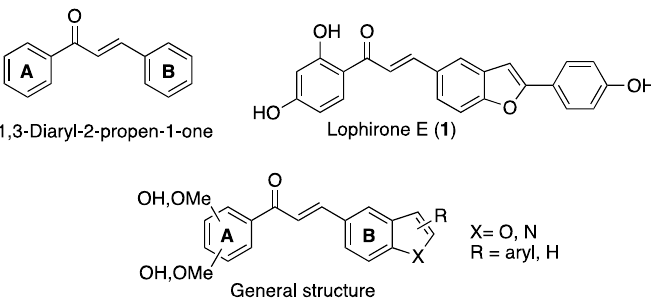
Figure 1. General structures of chalcones and compounds discussed in this work.